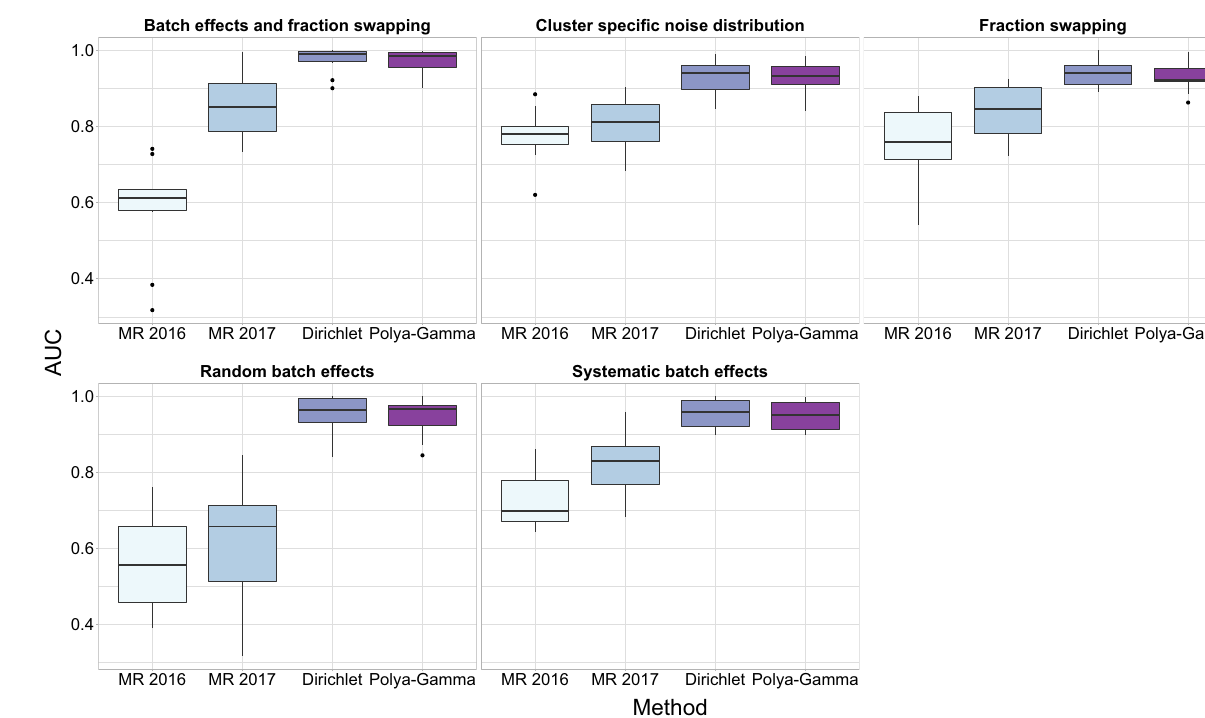
Fig. 2 | Comparison ofBANDLE withother approaches. Boxplots comparing the performance of the MR approach (2016 and 2017) and our proposed method BANDLE. BANDLE is separated into whether a Dirichlet-based prior was used or if the Polya-Gamma augmentation was applied. Each boxplot corresponds to a dif- ferent simulation scenario. The boxplots show BANDLE has signi fi cantly improved